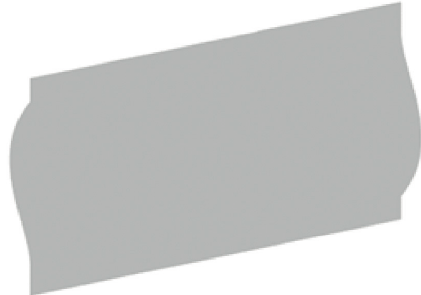
Figure 19: Explicit surface.